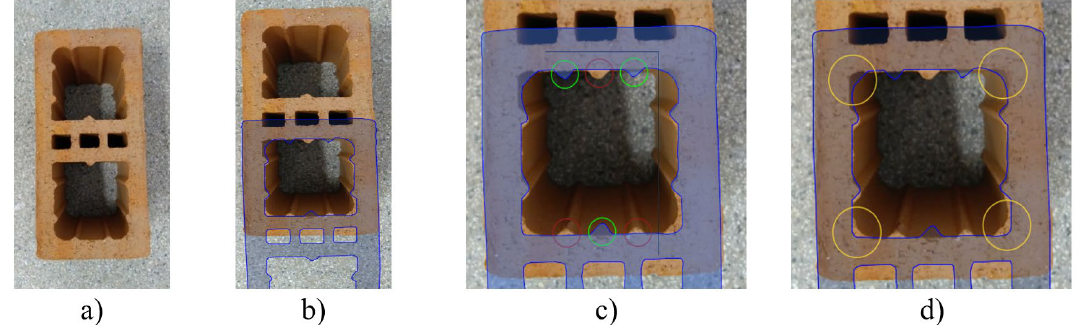
Figure 4. Indentations on the internal surface of the cells (block type BM7).